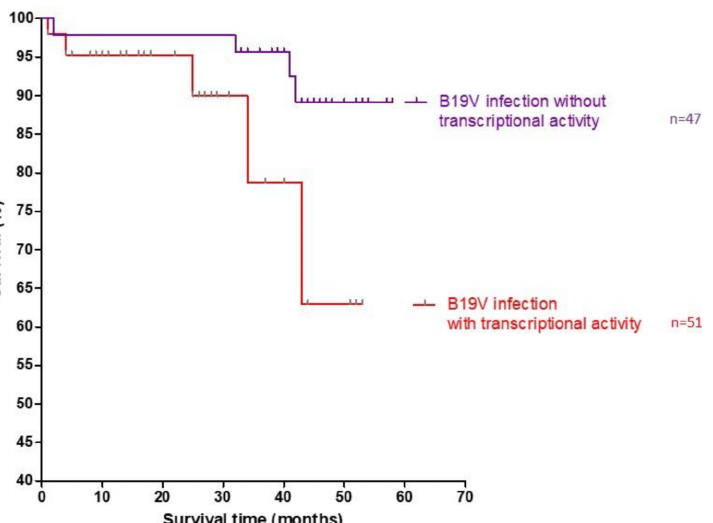
Figure 6. Kaplan–Meier plots. Natural all-cause mortality on long-term follow-up of B19V-positive patients with inflammatory cardiomyopathy in dependence of B19V transcriptional activity. The mortality rate was significantly higher in patients with transcriptional activity ( n = 52) compared to those without transcriptional activity ( n = 47) ( p = 0.04 by the log-rank